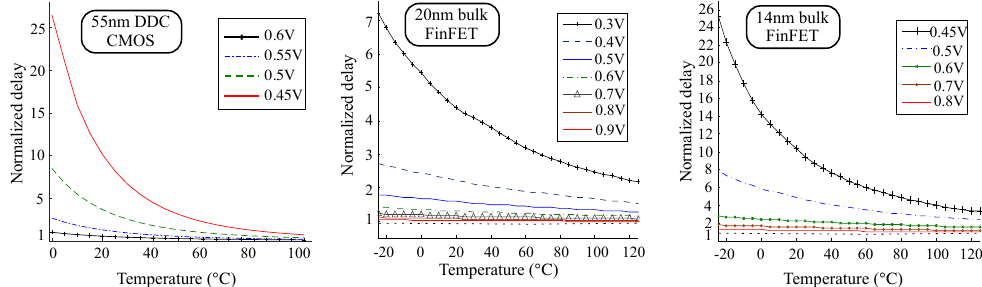
Figure 3. TEI phenomenons in 55 nm CMOS-based circuit and 20 nm/14 nm FinFET-based